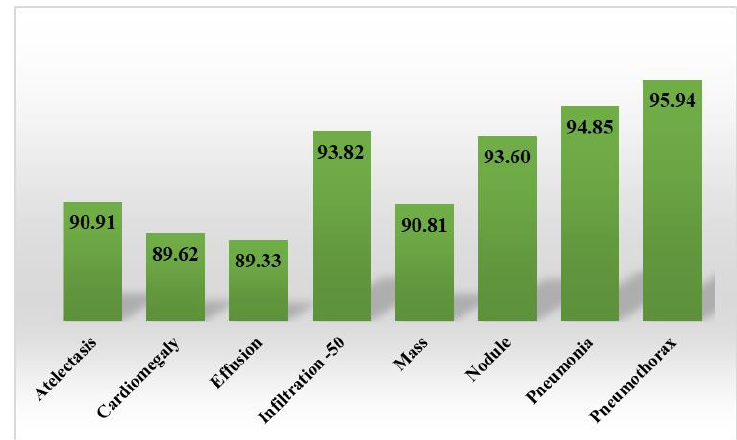
Figure 9. Category-wise recall scores for the CXray-EffDet model .